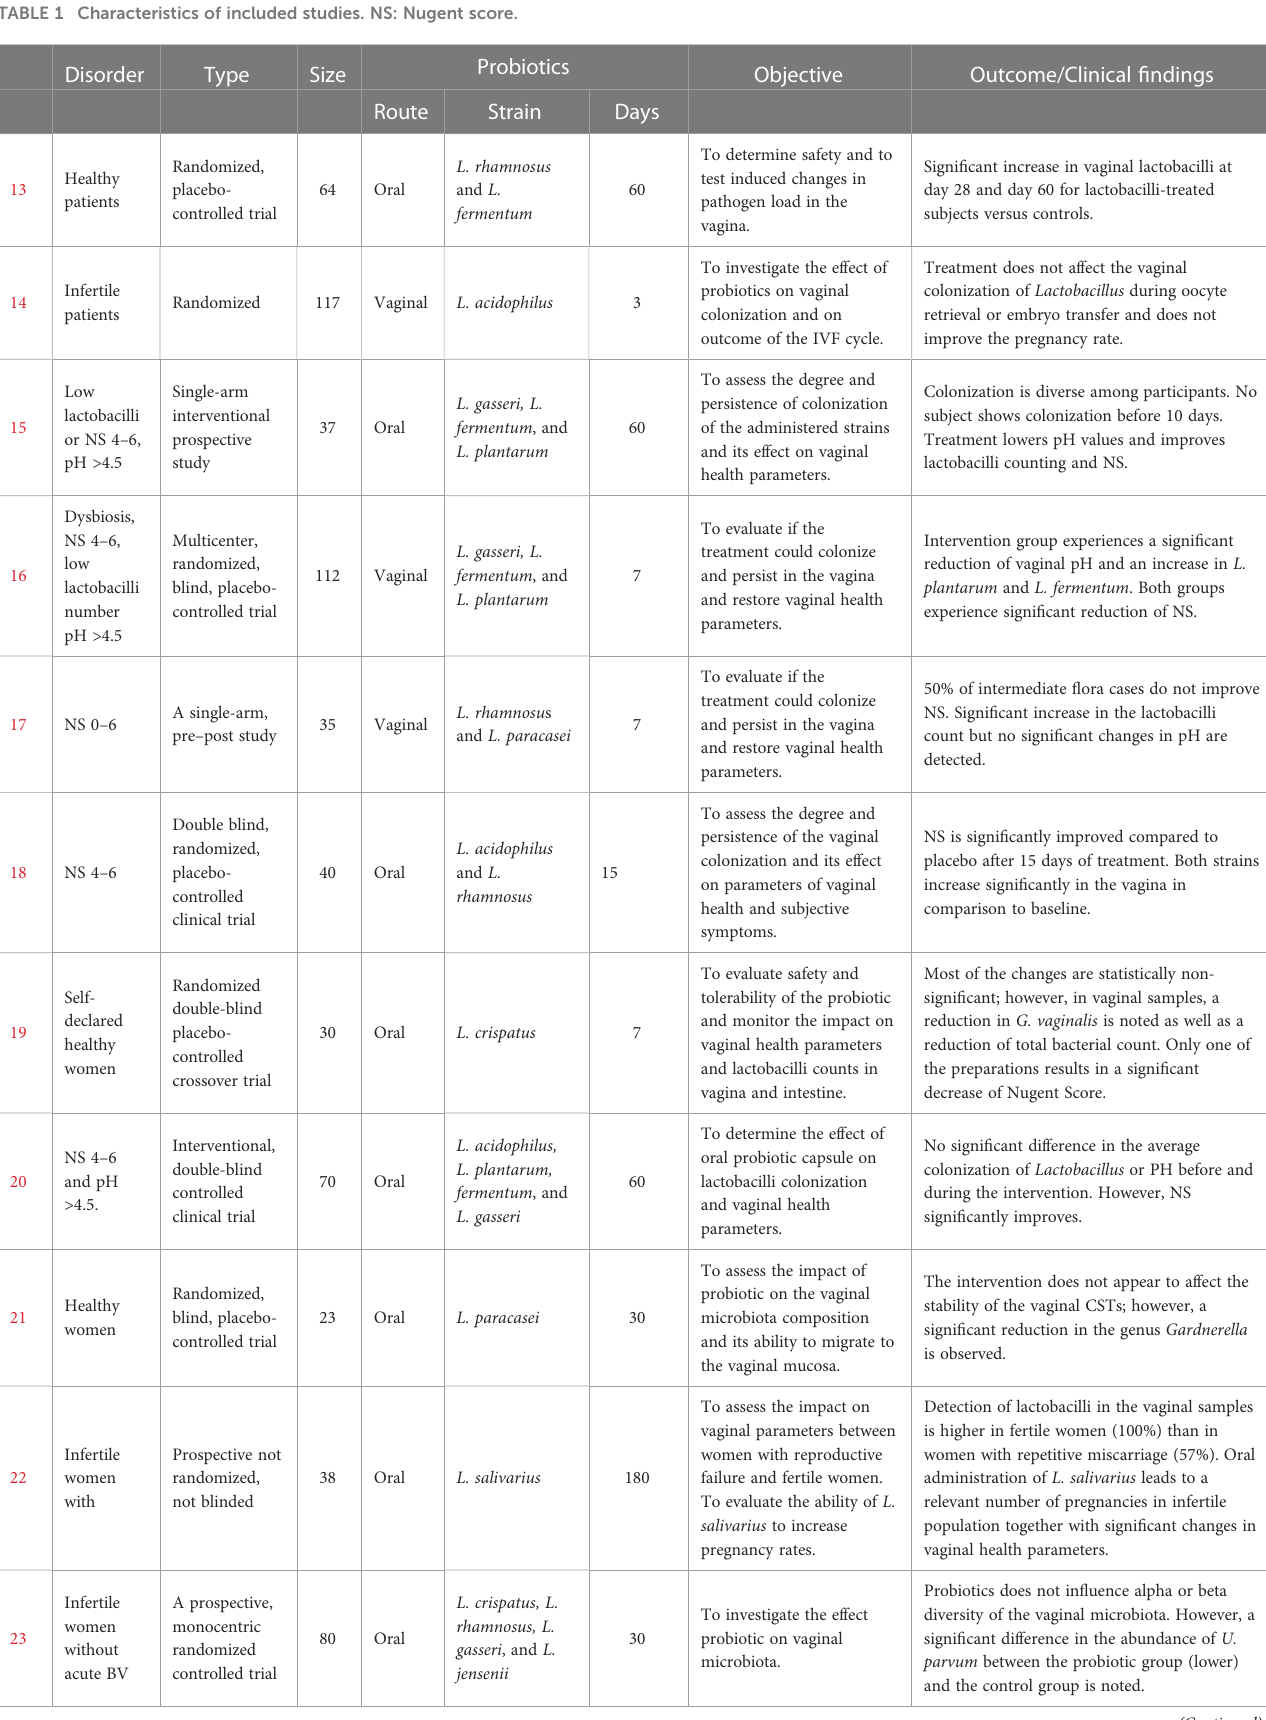
TABLE 1 Characteristics of included studies. NS: Nugent